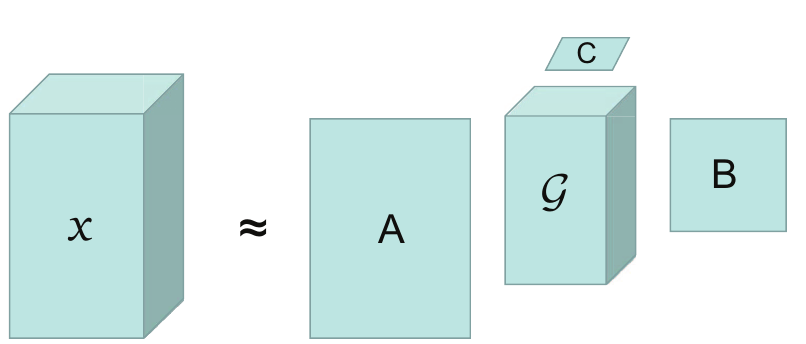
Figure 1. Diagrammatic presentation of a third-order tensor’s Tucker